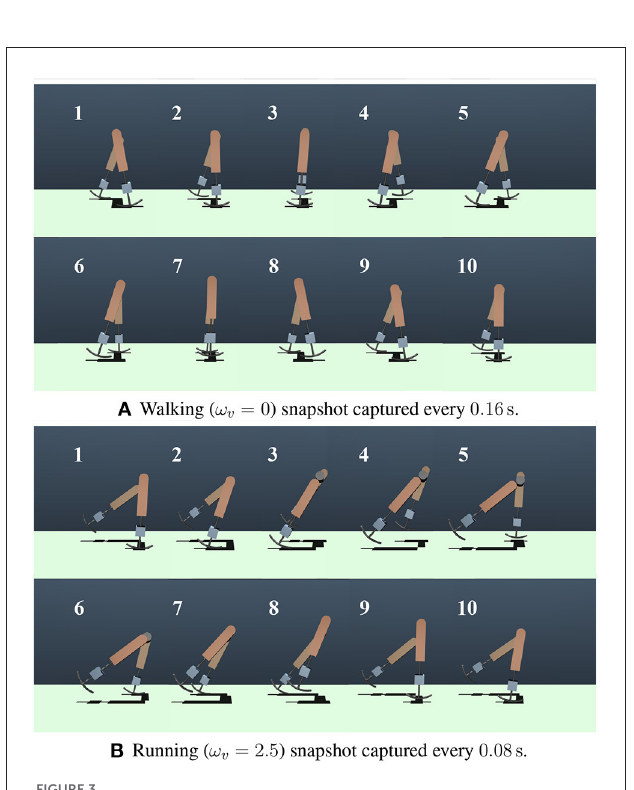
0). (B) Running ( ω v 2.5). = =